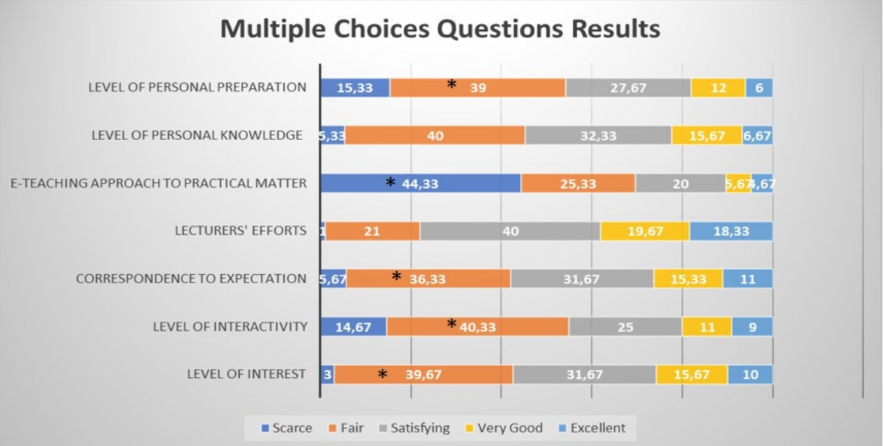
Figure 8. Questionnaire results for the overall combined student feedback to the e-learning and e-teaching approach, from the first to the sixth year of the course, inclusive. The numbers in the bars indicate the percentages of the answers received ( n = 301). * p < 0.05 (Kruskal–Wallis